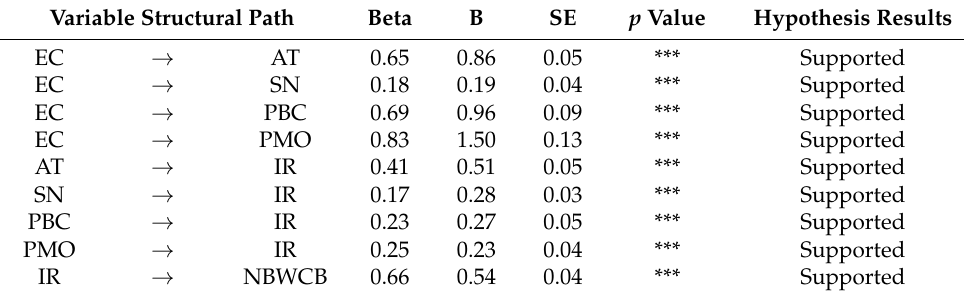
Table 4. Results of structural equation modelling (SEM).